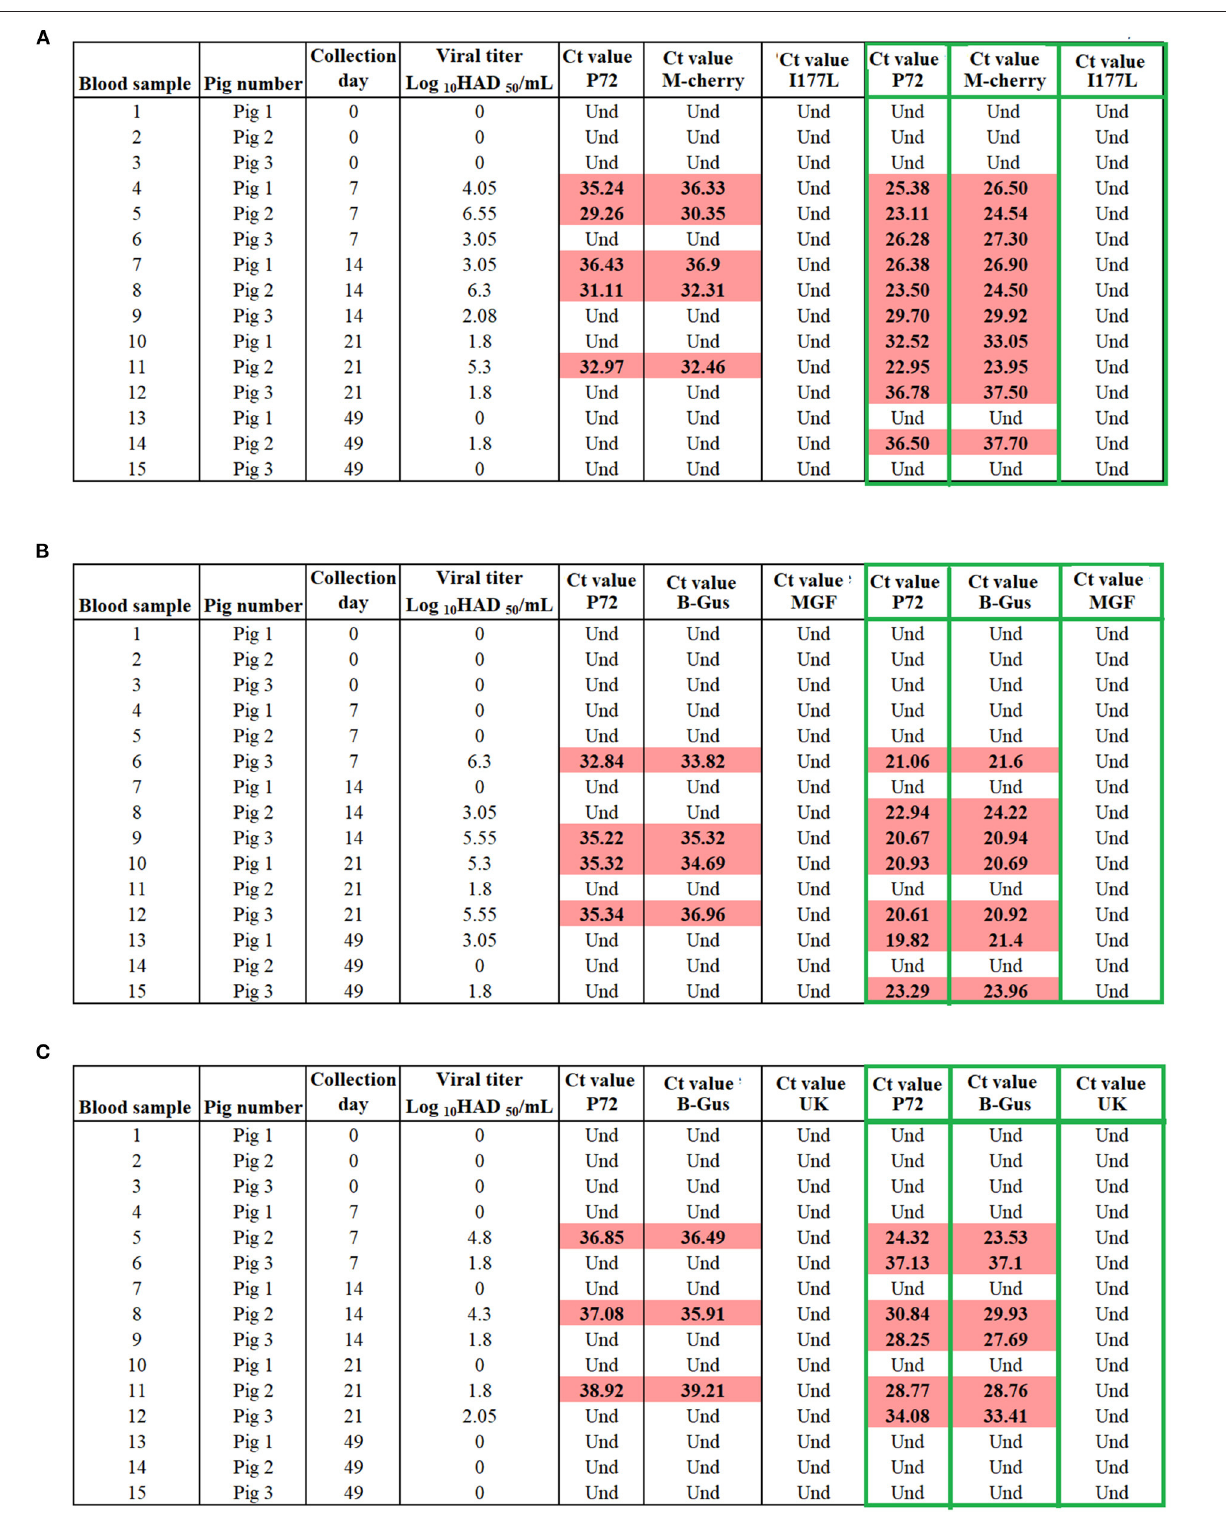
Frontiers in Veterinary Science |